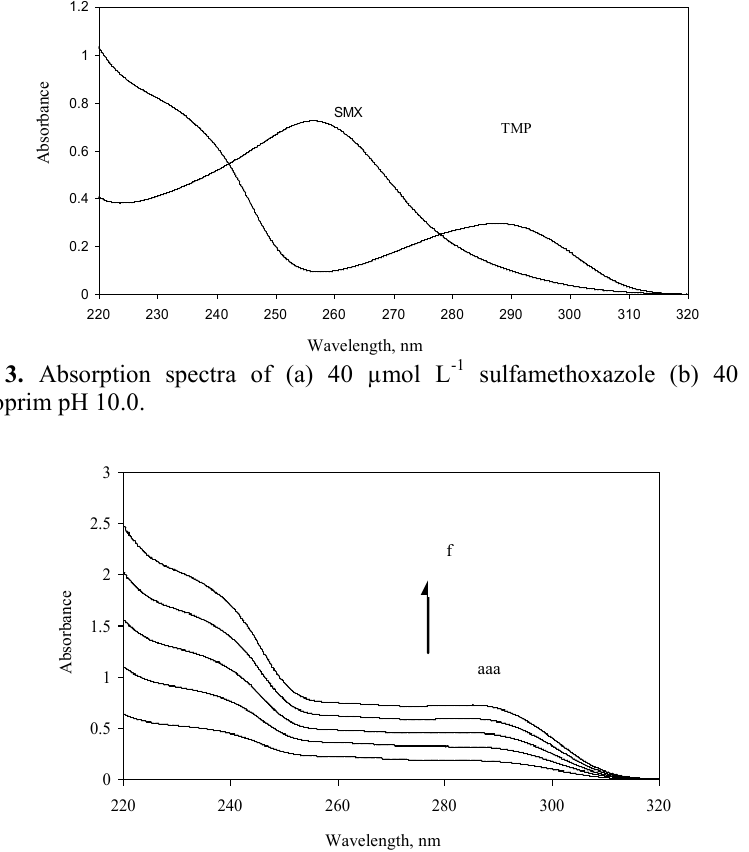
Figure 4. Absorption spectra of binary mixtures of SMX ( 10 µmol L -1 ) and TMP ( 20 µmol L -1 ) after addition of 0, 5, 10, 15 and 20 µmol L -1 SMX and 0, 15, 30, 45 and 60 µmol L -1 TMP (a-f) at pH